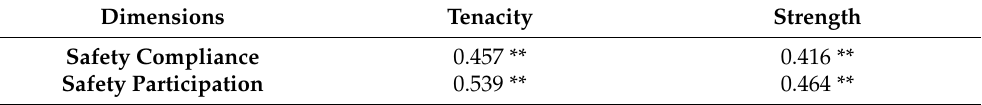
Table 6. Correlation coefficients of coal miners’ resilience and safety